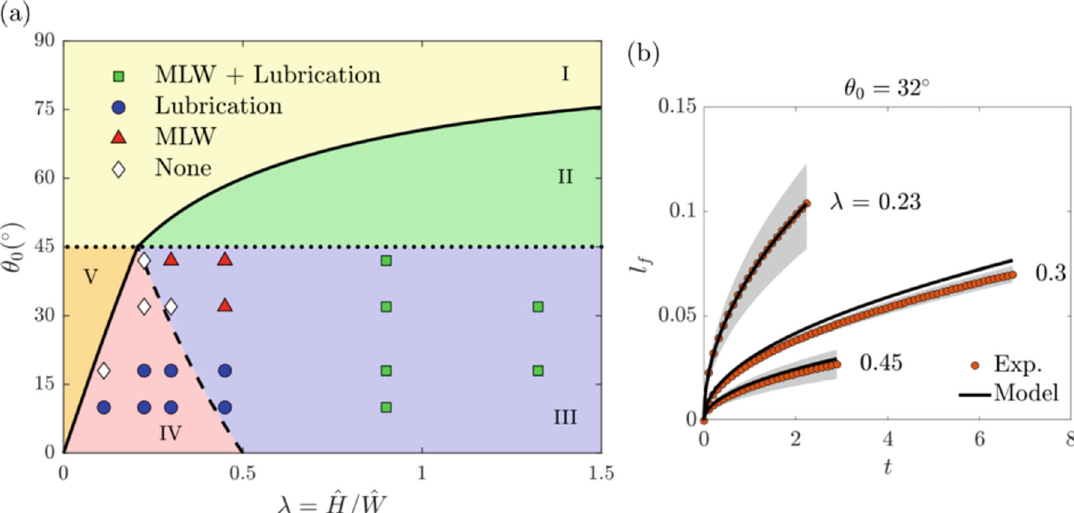
Fig. 2 Free-surface morphology and fi nger length. a Free-surface morphology diagram as a function of equilibrium contact angle θ 0 and channel aspect ratio λ . Solid symbols represent an agreement between lubrication-theory-based model and MLW model predictions with experiments 15 . The solid line corresponds to the limit where the capillary fl ow of the meniscus is energetically favorable in an open rectangular channel 54 . The dotted line corresponds to the contact-angle limit below which fi ngers form 47 . The dashed line corresponds to the critical aspect ratio at which fi ngers transition from a pinned to an unpinned state at the top of channel sidewall 15,54 . Region I has no capillary fl ow of the meniscus, region II has no fi ngers present, region III has fi ngers that are not pinned to the top of the channel sidewall, region IV has fi ngers that are pinned to the top of the channel sidewall, and region V has a capillary fl ow of fi ngers but not of the meniscus. b Effect of ^ l f = ^ L as a function of dimensionless time t ¼ ^ t ^ H ^ σ = ^ L 2 ^ μ , where ^ L is the channel length 15 . Solid aspect ratio λ on dimensionless fi nger length l f ¼ symbols and shaded areas represent the average and range of experimental results, respectively. Solid lines represent lubrication-theory- based model